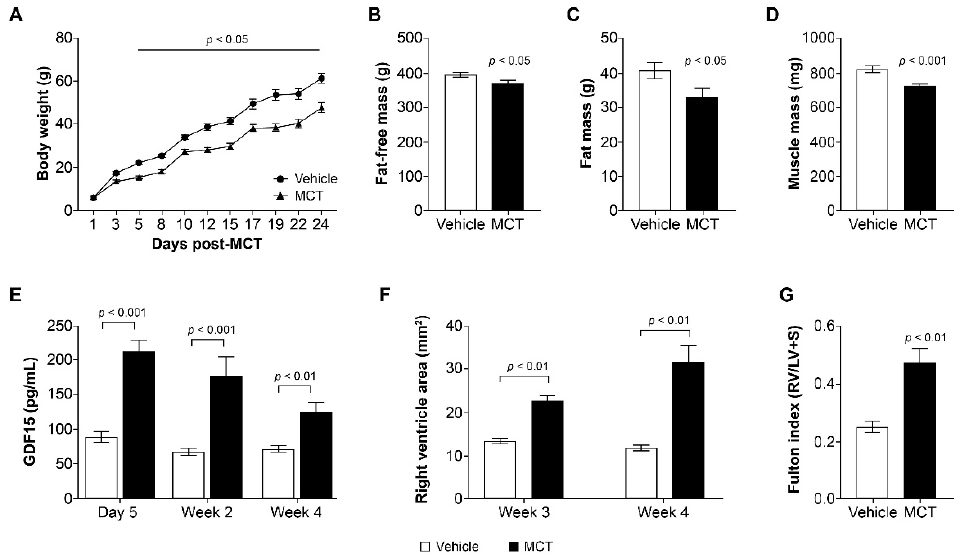
Figure 1. MCT treatment increased GDF15 and caused cachexia and RVD in rats. ( A ) Change in body weight (g) from baseline on days 1–24; p < 0.05 MCT group vs. vehicle from day 5 onward. Data were analyzed with a longitudinal mixed-effects model with an AR(1) covariance structure. ( B ) Fat-free mass at 3 weeks post MCT; p < 0.05 MCT group vs. vehicle. Data were analyzed using a Welch’s two-sample t -test. ( C ) Fat mass at 3 weeks post MCT; p < 0.05 MCT group vs. vehicle. Data were analyzed using an unpaired t -test. ( D ) Muscle mass (tibialis anterior) at 3 weeks post MCT; p < 0.001 MCT group vs. vehicle. Data were analyzed using a Welch’s two-sample t -test. ( E ) Circulat- ing GDF15 levels (pg/mL) measured at day 5, week 2, and week 4; p < 0.01 week 4, p < 0.001 day 5 and week 2 MCT group vs. vehicle. Data were analyzed with a longitudinal mixed-effects model with an AR(1) covariance structure. ( F ) Right-ventricular dysfunction according to right-ventricular area (mm 2 ) measured at weeks 3 and 4; p < 0.01 MCT group vs. vehicle. Data were analyzed with a longitudinal mixed-effects model with an AR(1) covariance structure. ( G ) Fulton index (RV/LV + S) measured at week 4; p < 0.01 MCT group vs. vehicle. Data were analyzed using a Welch’s two- sample t -test. Data are presented as the least squares mean ± SEM. ANOVA: analysis of variance; GDF15: growth and differentiation factor 15; LV: left ventricle; MCT: monocrotaline; RV: right ven- tricle; RVD: right-ventricular dysfunction; SEM: standard error of the mean; S: septum.